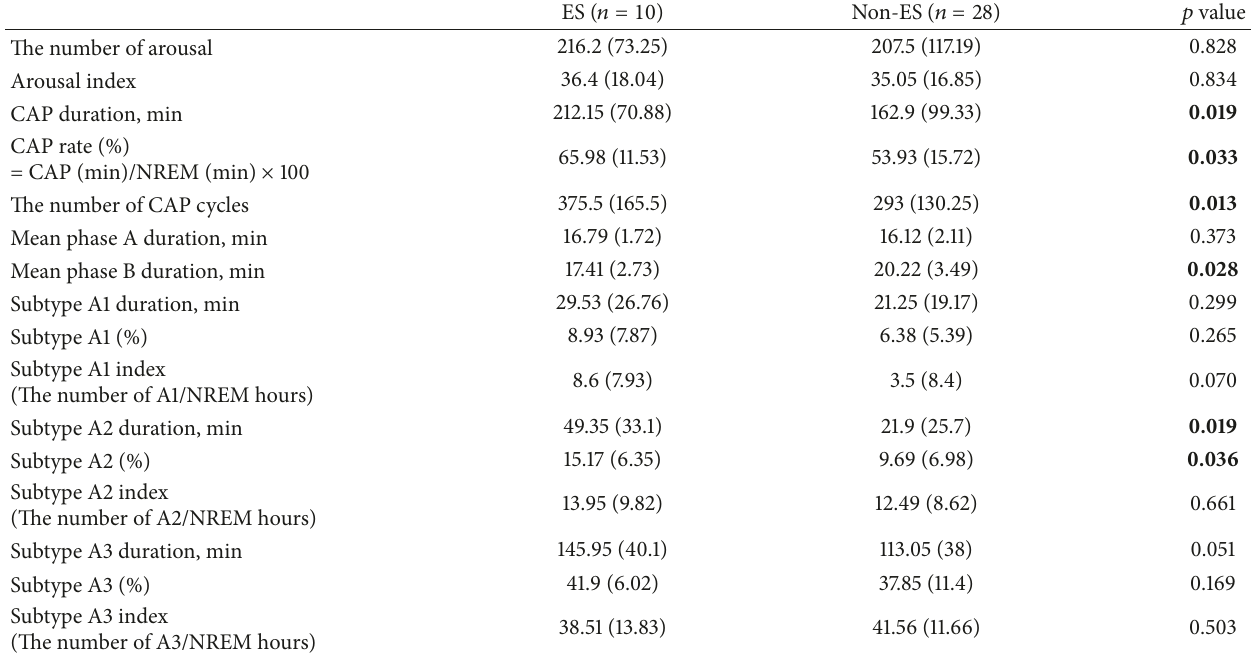
Table 3: Comparison of parameters of sleep microstructure in OSA patients with and without ES (ES versus